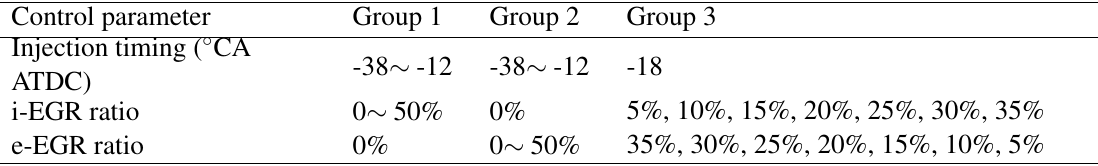
Table 5 Test points of three